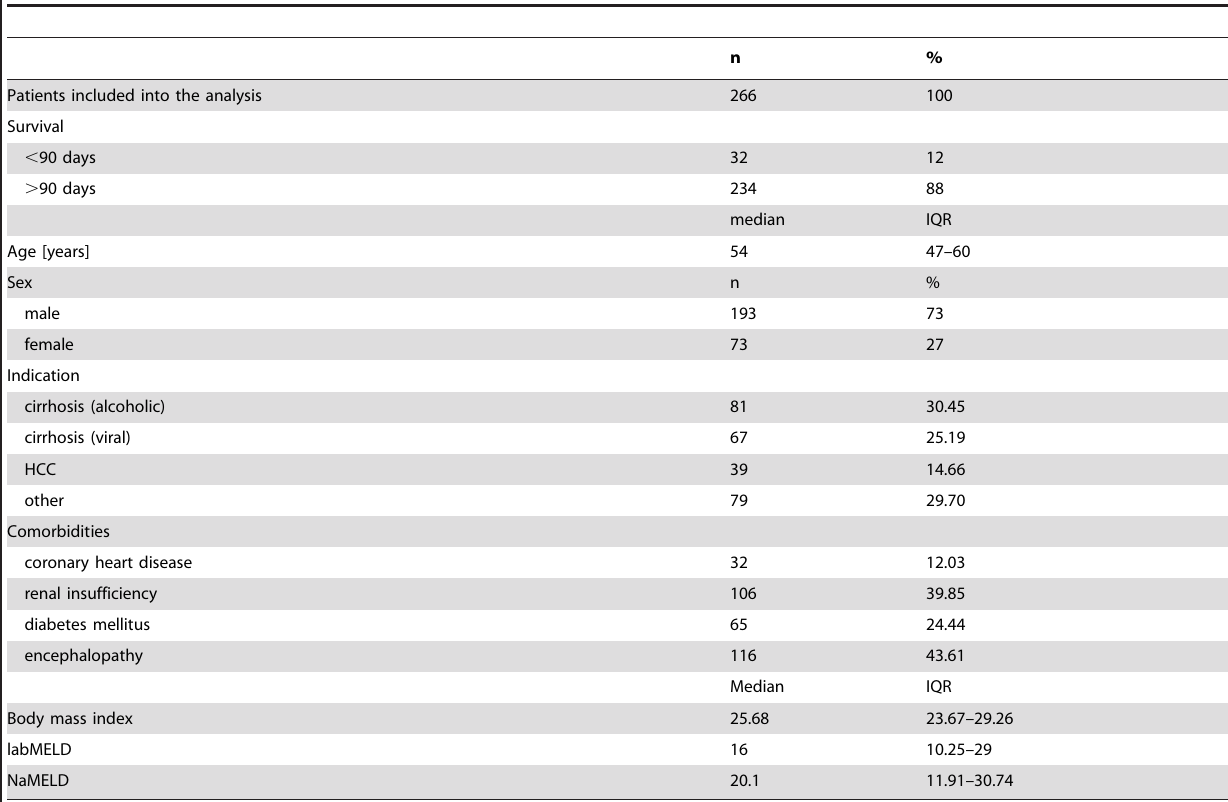
Table 1. Recipient characteristics.